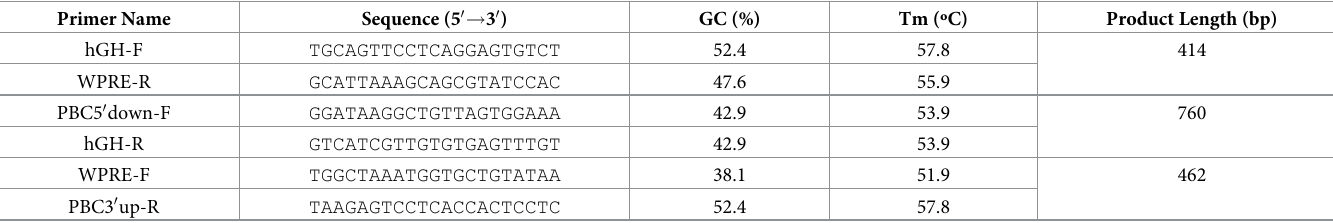
Table 1. Primer pairs for PCR